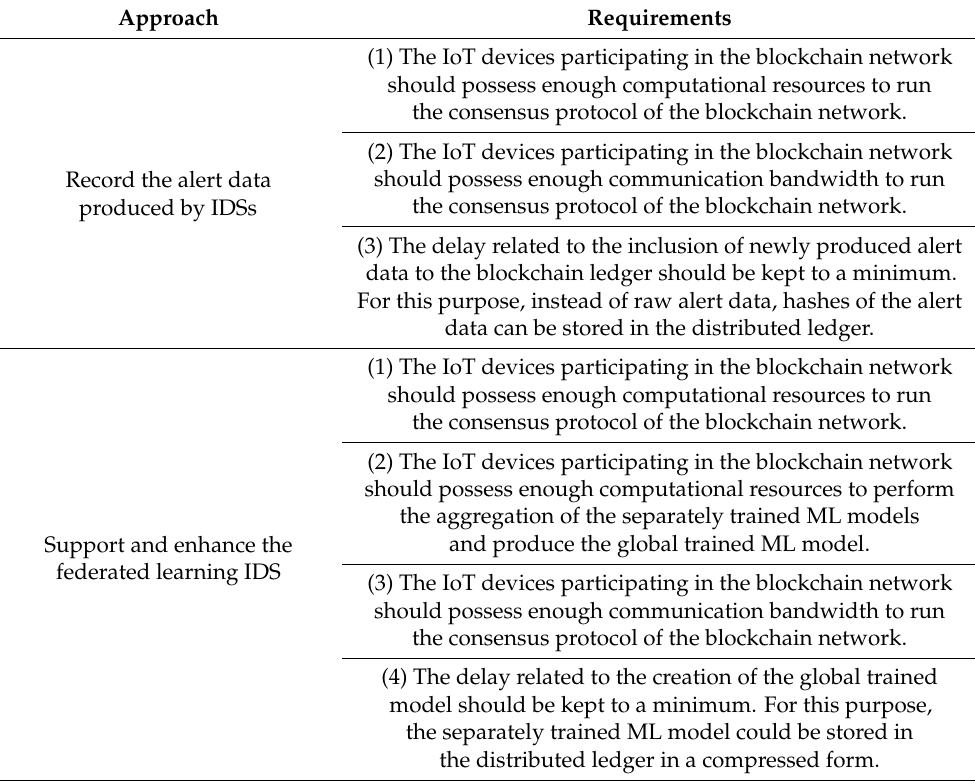
Table 6. Requirements of the two approaches described in [54,57–59] for blockchain-based IDS in IoT